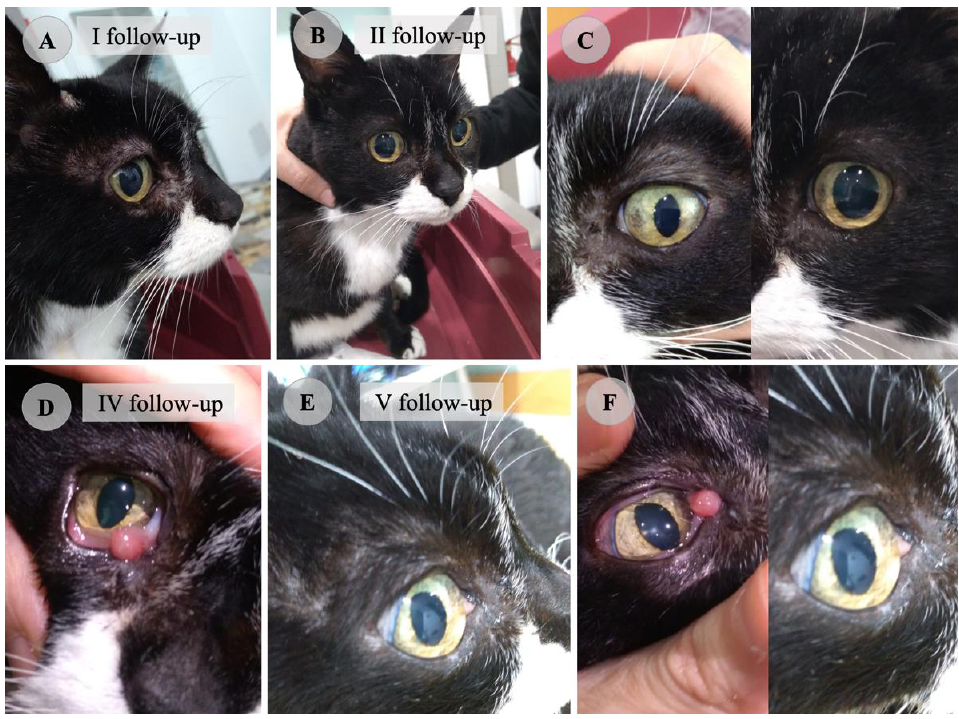
Figure 2. Evolution of clinical signs in a leishmaniotic cat treated with allopurinol 10 mg/kg PO q 12 h. ( A ) First follow-up and ( B ) two-months follow-up. ( C ) Comparison of the same periocular region before and after the treatment. ( D ) First relapse at the IV follow-up, ( E ) the improvement of the lesion after treatment, ( F ) and the resolution of the ocular granuloma after the treatment with allopurinol.